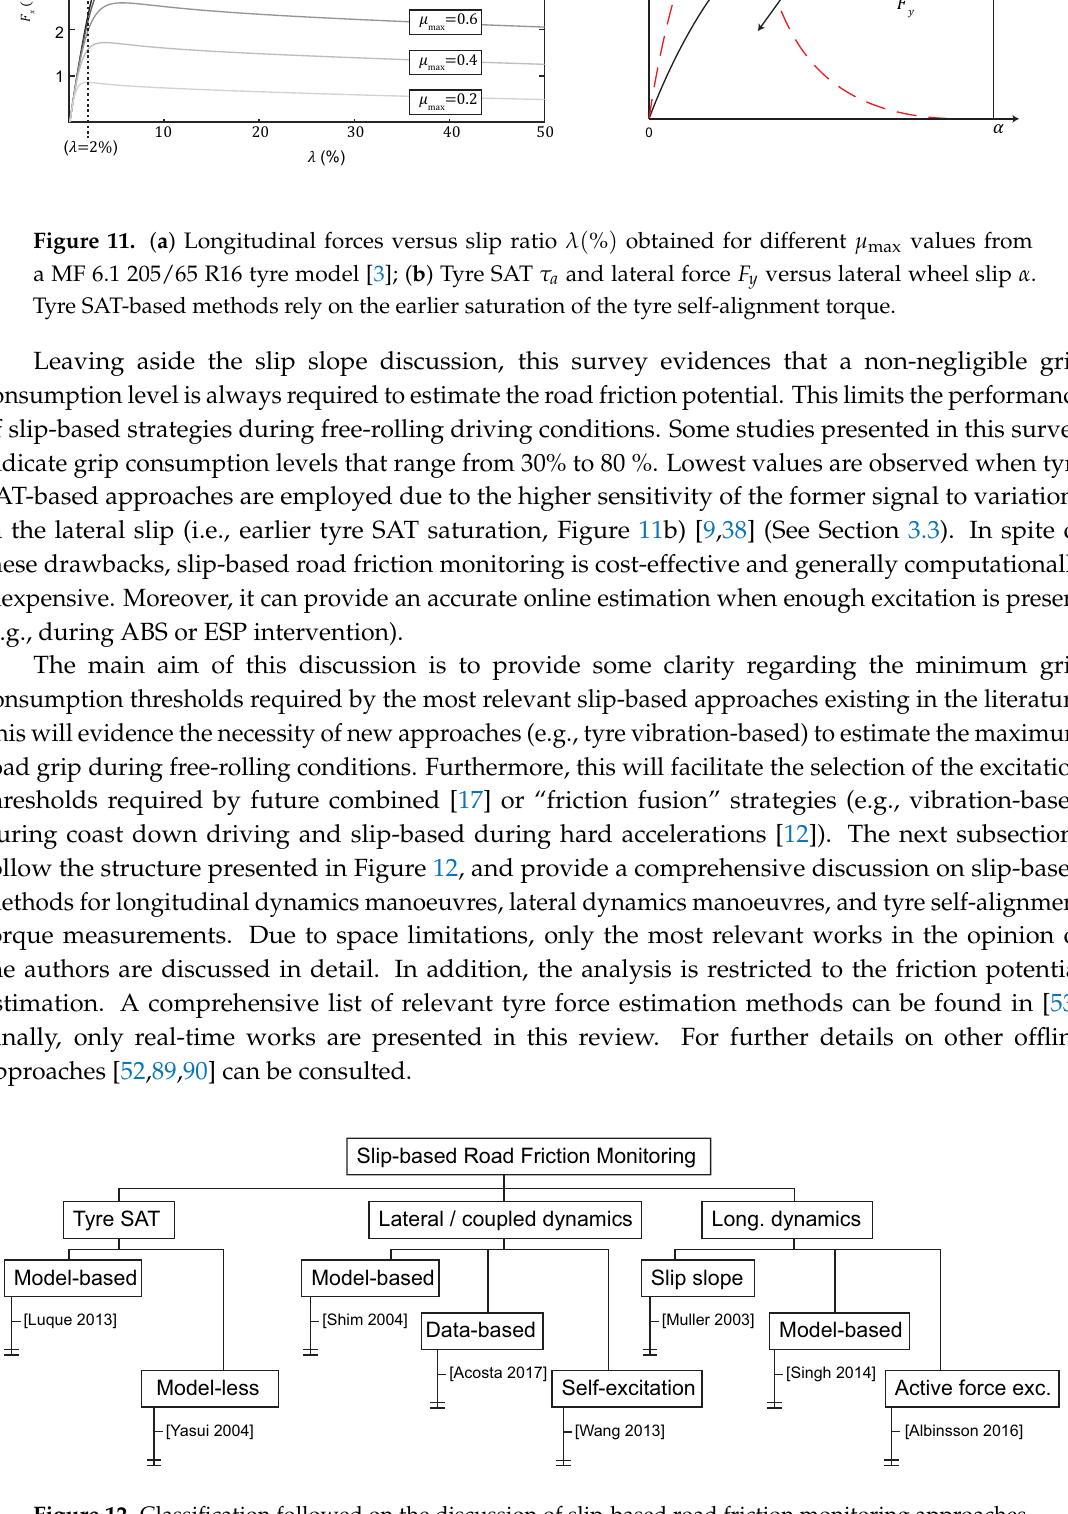
Figure 12. Classification followed on the discussion of slip-based road friction monitoring